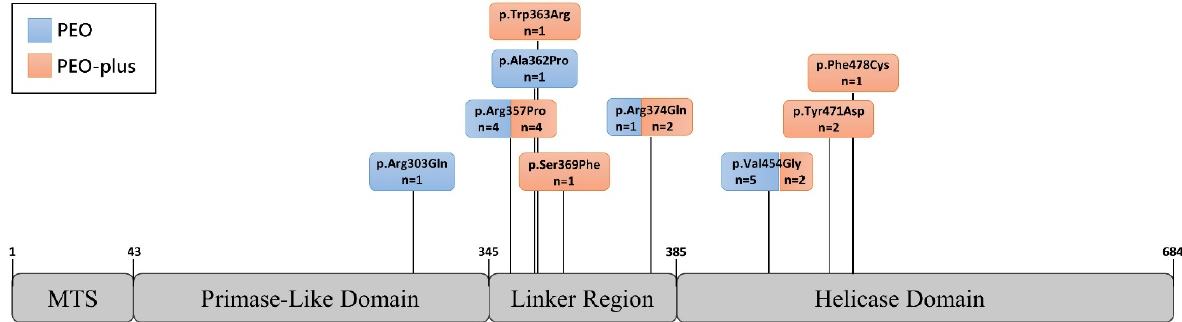
Figure 2. Phenotypic features depending on the affected protein domain. TWNK protein represen- tation showing the distribution of the mutations identified in our cohort along the domains of the protein and the number of patients presenting PEO (blue) or PEO-plus (orange) phenotype for each variant. PEO: progressive external ophthalmoplegia. MTS: mitochondrial targeting sequence. Num- bers on the TWNK protein denote the aminoacidic residue delimiting the domains.